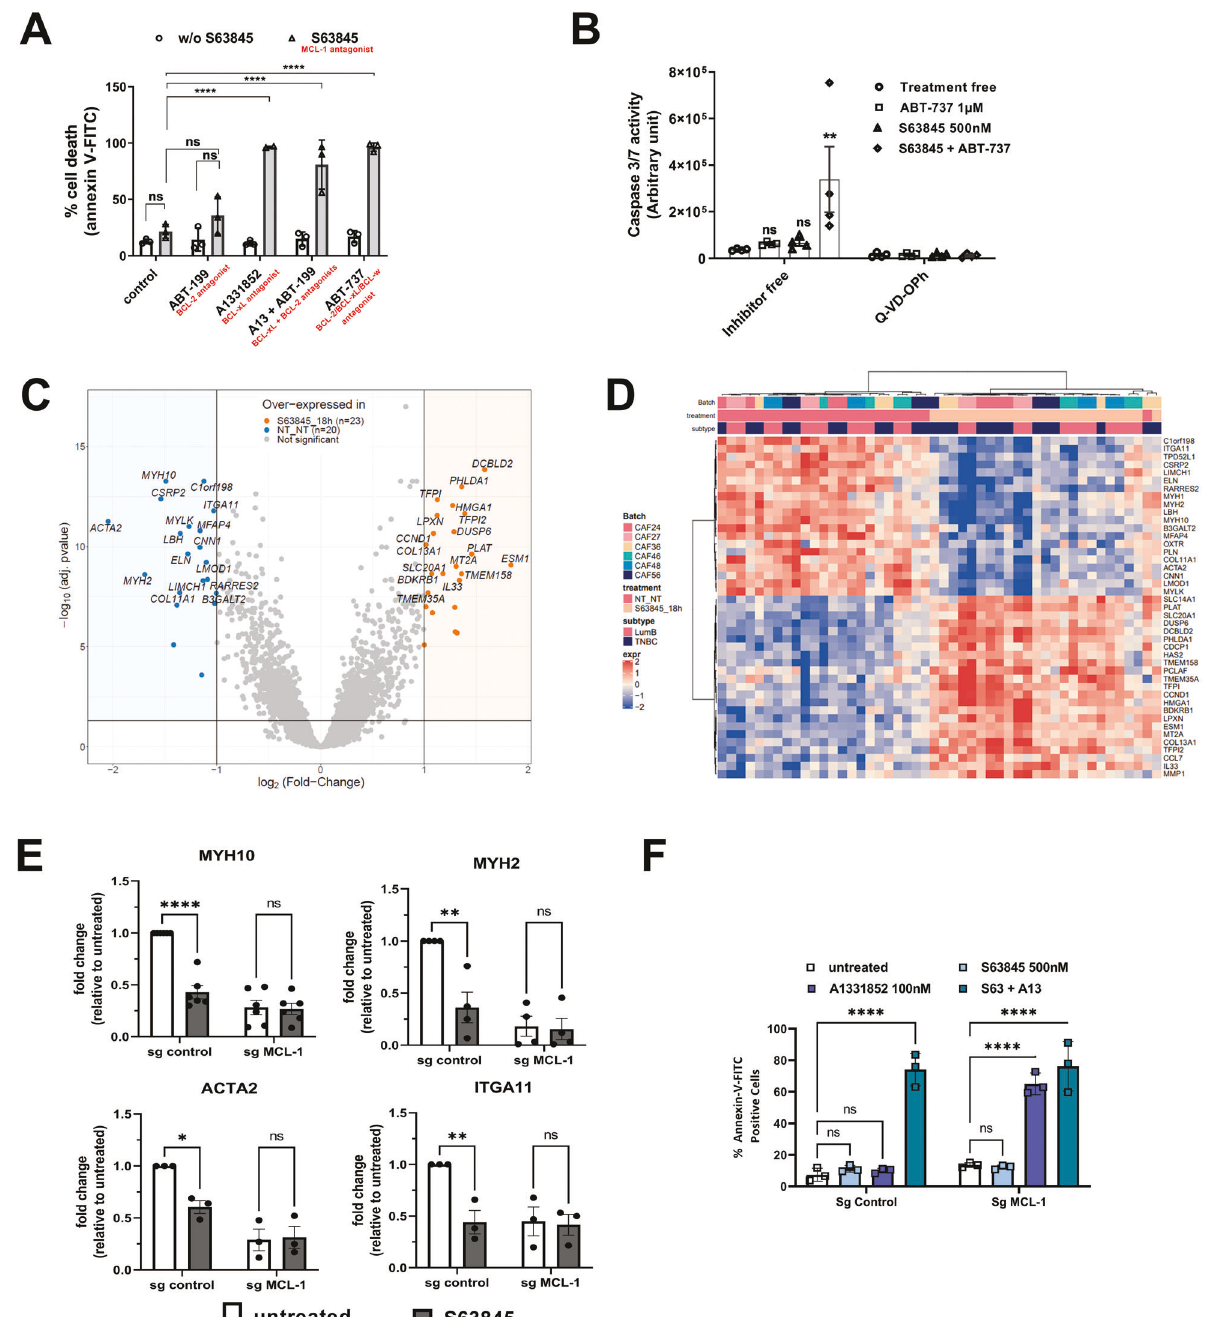
Fig. 1 MCL-1 targeting in fl uences transcriptional programs involved in actomyosin organization/contractility in viable bCAFs. A Three different primary cultures of CAFs were treated with ABT-199 (1 µM), A1331852 (100 nM), ABT-199 (1 µM) + A1331852 (100 nM) or ABT-737 (1 µM) with or without S63845 (500 nM) for 72 h in DMEM containing 1% FBS, apoptosis was measured by Annexin-V fl ow cytometry. Data are means ± SEM from three independent experiments. Two-way ANOVA, **** P < 0.0001, ns: not signi fi cant. B Caspase 3/7 activity was measured by caspase Glo assay and expressed in arbitrary unit. Data are means ± SEM from four independent experiments. Two-way ANOVA. * P < 0.05, ns: not signi fi cant C Volcano plot displaying differential expressed genes between S63845 treated and non-treated primary culture of CAFs from luminal B ( n = 3) and triple negative ( n = 3) breast cancers. The vertical axis ( y -axis) corresponds to the mean expression value of log 10 ( q -value), and the horizontal axis ( x -axis) displays the log2 fold-change value. The red dots represent the upregulated expressed transcripts; the blue dots represent the transcripts whose expression is downregulated. D A hierarchically clustered heatmap showing the expression patterns of the 23 most extreme DE mRNA. Red and blue represent up- and downregulated expression in CAFs treated or not with S63845. Color density indicating levels of fold-change was displayed. E qRT-PCR of MYH10, MYH2, ACTA2 andITGA11 mRNA in CAFs Sg control or sg MCL-1 treated or not by S63845 500 nM for 18 h. Mean and SEM of three independent experiments are represented as fold-change of mRNA level related to untreated Sg control. Two-way ANOVA, * P < 0.1, ** P < 0.01, **** P < 0.0001, ns: not signi fi cant. F CAFs sg control or silenced for MCL-1 (sg MCL-1) were treated or not with S63845 (500 nM), A1331852 (100 nM) or S63845 (500 nM) + A1331852 (100 nM) for 48 h in DMEM containing 1% FBS. Apoptosis was measured by Annexin-V fl ow cytometry. Data are means ± SEM from three independent experiments. P - value was determined by two-way ANOVA. **** P < 0.0001, ns: not signi fi